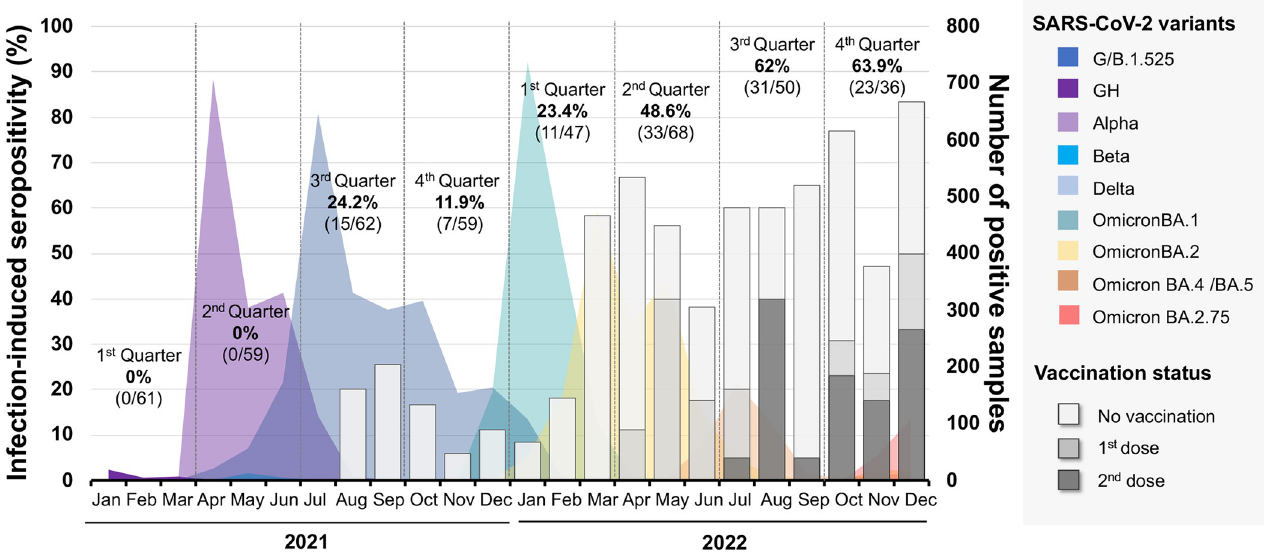
Fig 2. Monthly infection-induced seroprevalence in children and distribution of SARS-CoV-2 variants between January 2021 and December 2022. A total of 442 sera samples collected from Thai children were used to determine the presence of SARS-CoV-2 antibodies to estimate SARS-CoV-2 infection-induced seropositivity. SARS-CoV-2 infection-induced seropositivity was defined as the seropositivity of anti-N IgG or anti-RBD antibody for unvaccinated individuals and anti-N IgG seropositivity or having reported SARS-CoV-2 infection for vaccinated individuals with the BNT162b2 vaccine. The stacked bar graph represents the percentage of infection-induced seropositivity according to the vaccination status (left Y-axis). The vertical dotted lines indicate the quarter, and the number above the bar graph indicates infection-induced seropositivity estimated for each quarter. Color shaded areas indicate the number of nasopharyngeal swab samples that tested positive (right Y axis) and subsequently identified the SARS-CoV-2 variants (n = 7,729) that was obtained from our previous study [7]. Data on SARS-CoV-2 variants were identified using sequencing and multiplex real-time reverse transcription polymerase chain reaction (RT-PCR) to depict the predominant wave for individual SARS-CoV-2 variants in Thailand.